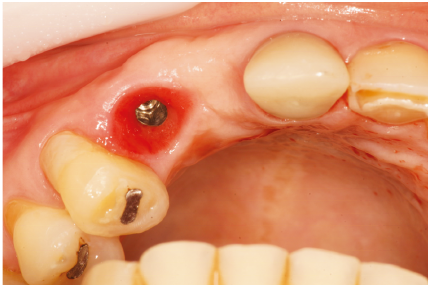
Figure 10: Final appearance of the implant